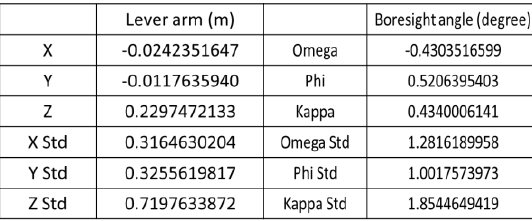
Figure 13 EOP results from POS trajectory Table 2 Boresight angle/Lever arm calibration result